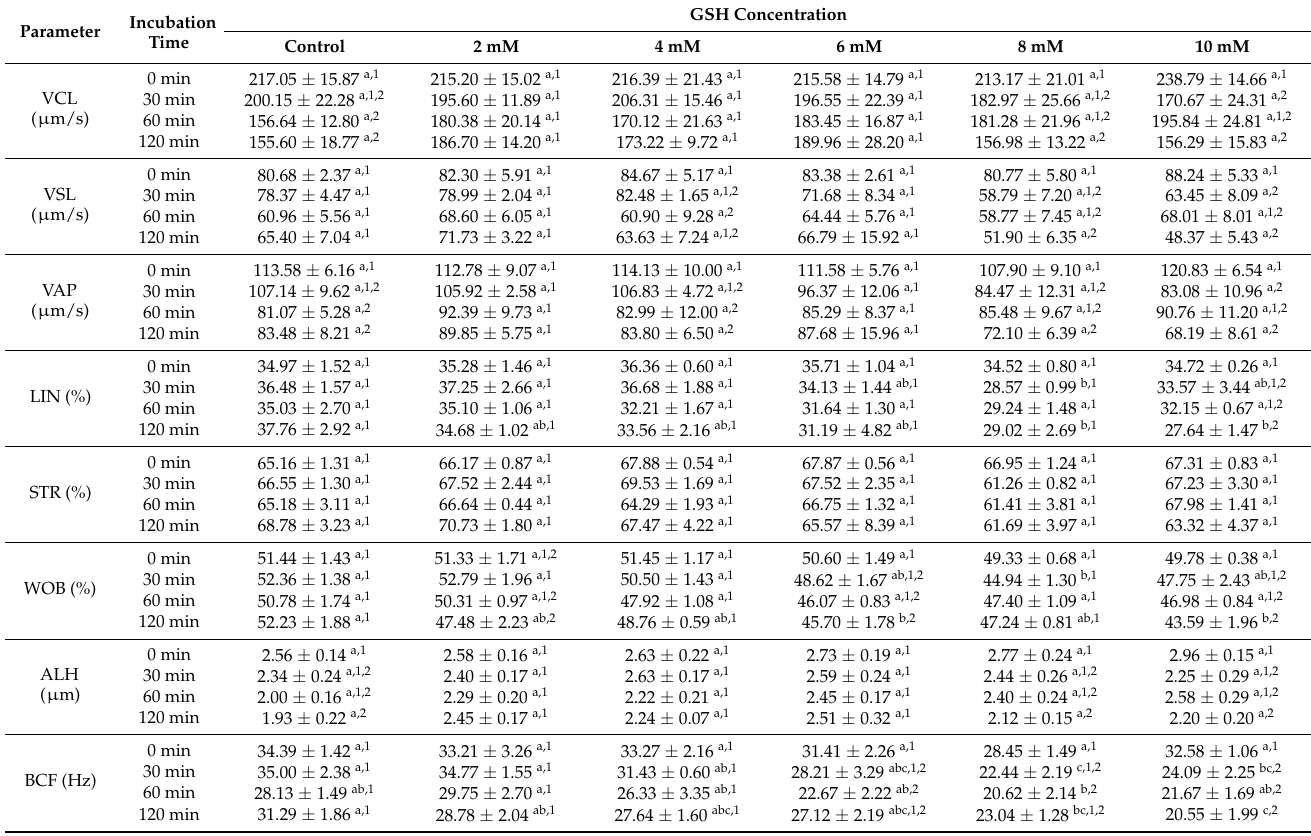
Table 1. Mean ± SEM of the kinematic parameters of donkey sperm exposed to reductive stress with different reduced glutathione (GSH) concentrations measured at different incubation